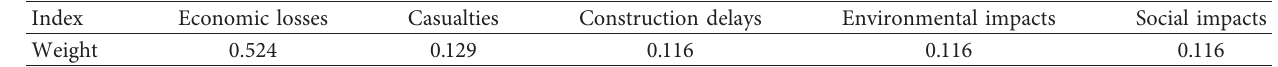
Table 8: The weights of the five indicators of the consequence severity (expert